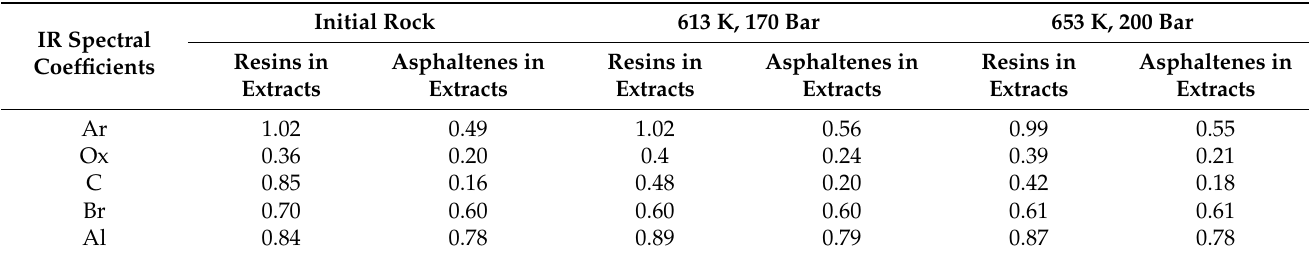
Table 1. Structural parameters according to IR spectroscopy.